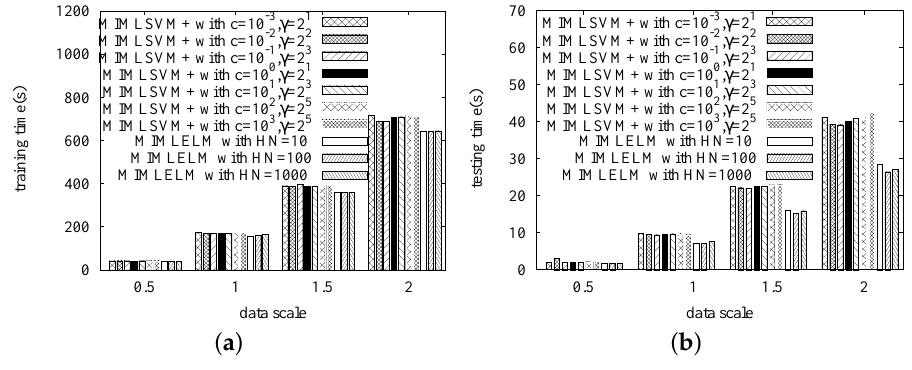
Figure 5. The efficiency comparison on the Image dataset. ( a ) The comparison of the training time; ( b ) the comparison of the testing time.